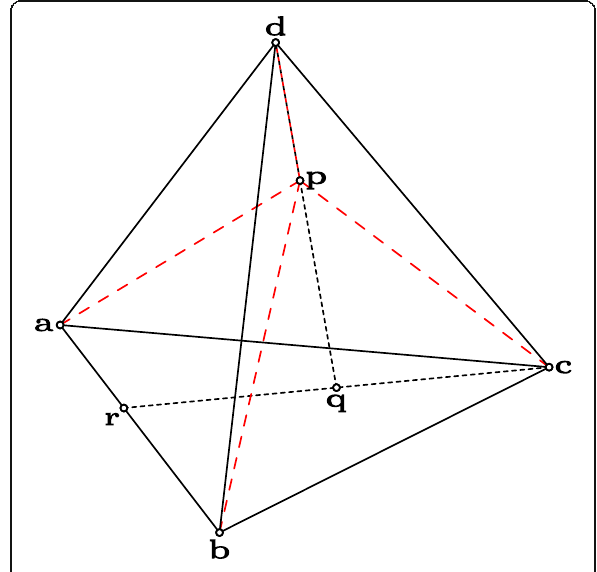
Fig. 1 Barycentric coordinates of point p inside the tetrahedron abcd. In the figure, r = (1 – 0.4) a + 0.4 b , q = (1 – 0.5) r + 0.5 c , and p = (1 – 0.6 q ) + 0.6 d . Using the computation method proposed below to obtain t, u, v, and w barycentric coordinates of p , we get that p = 0.12 a + 0.08 b + 0.2 c + 0.6